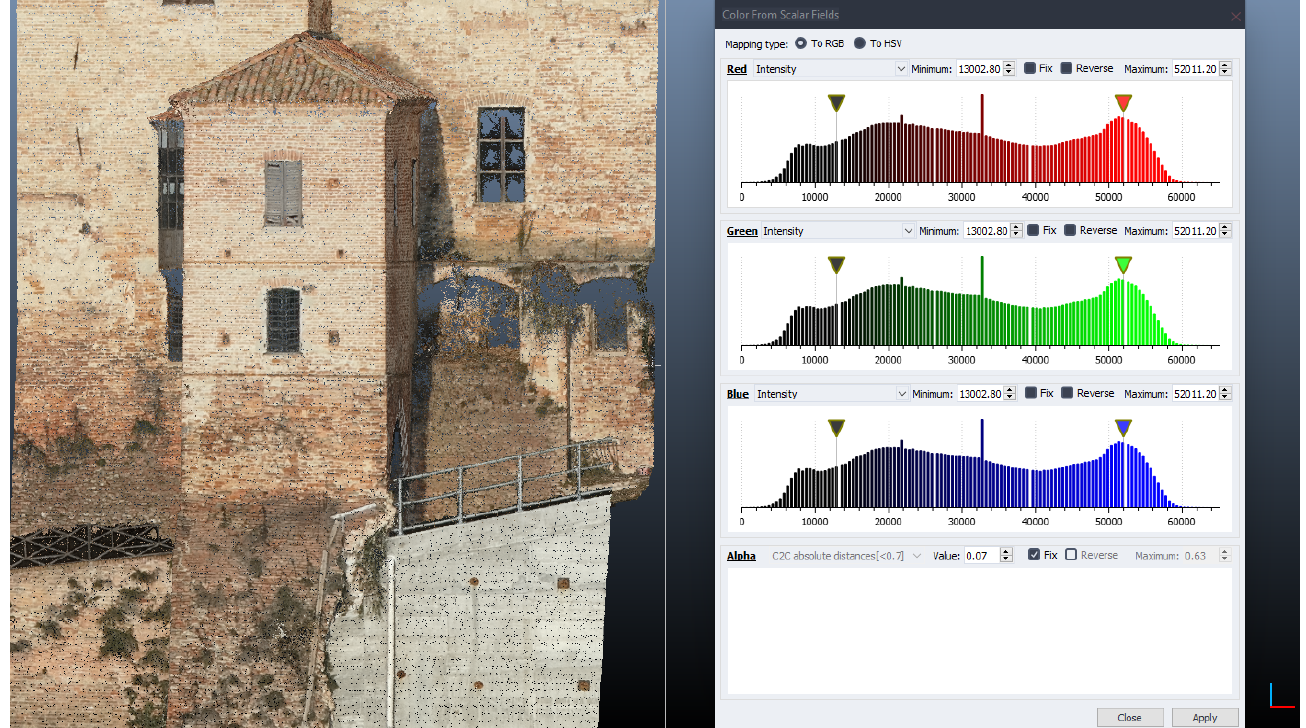
Figure 29. Roughness analysis of the L1 LiDAR sensor: RMSe 0.041 m; standard deviation 0.026 m. White points are related to roughness and noise record.